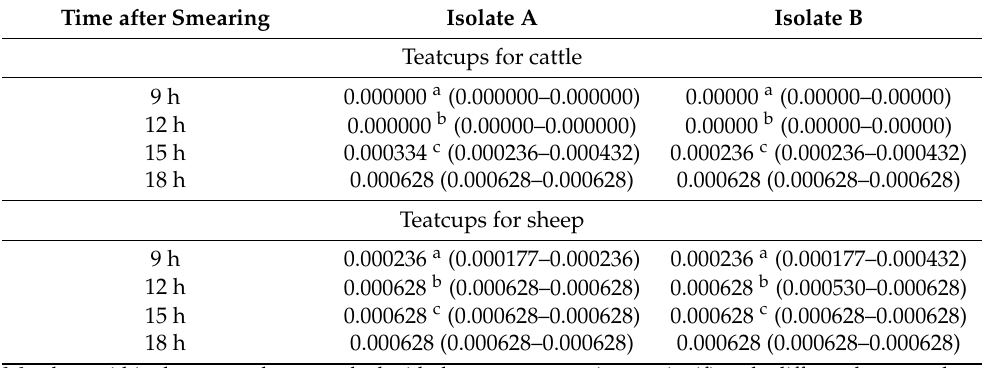
Table 2. Median (min–max) surface covered (m 2 ) by two isolates of S. epidermidis at different